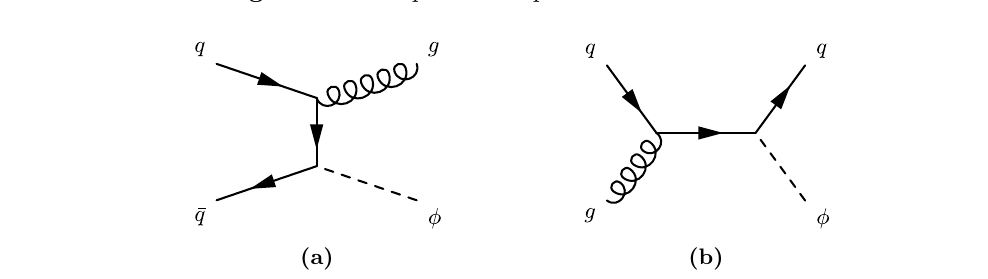
Figure 7. Examples of production from